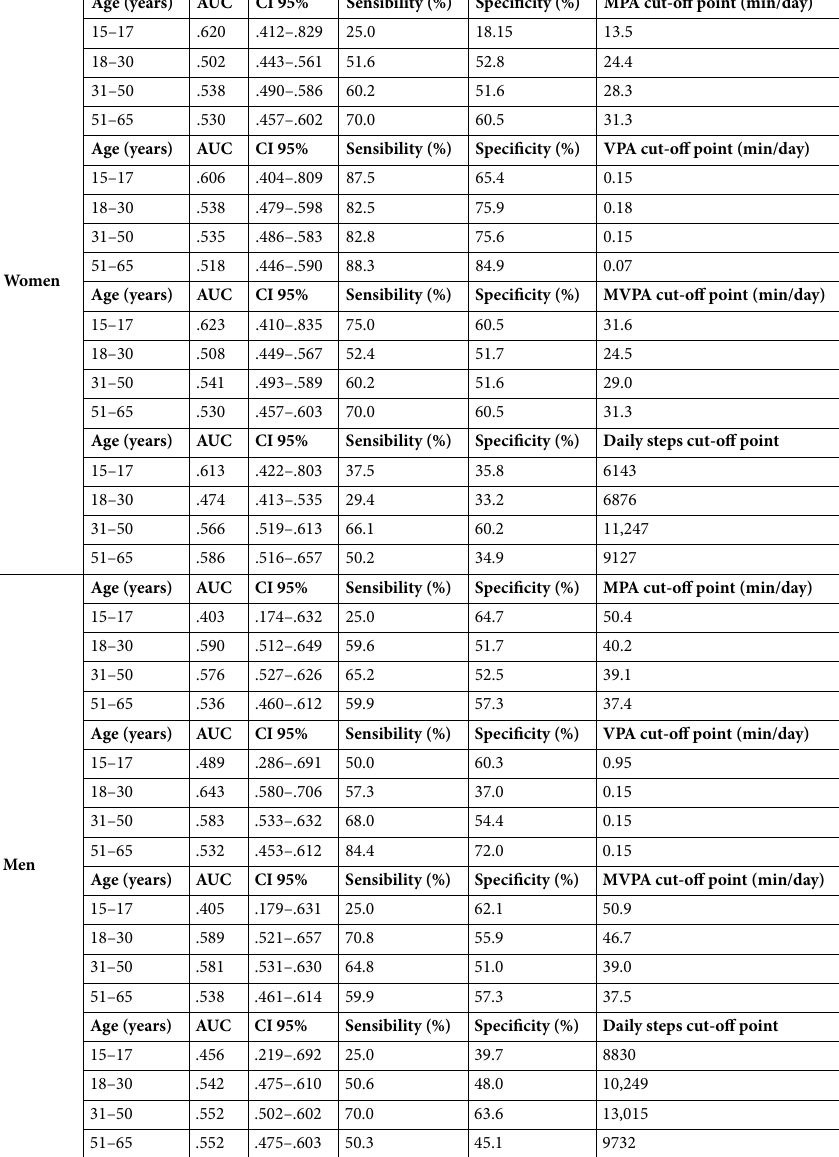
Table 4. Physical activity cut-off points (min/day) and number of steps according to sex and age categories in relation to WHtR. AUC, area under the curve; CI 95%, confidence interval; MPA, moderate physical activity; VPA, vigorous physical activity; MVPA, moderate-to-vigorous physical